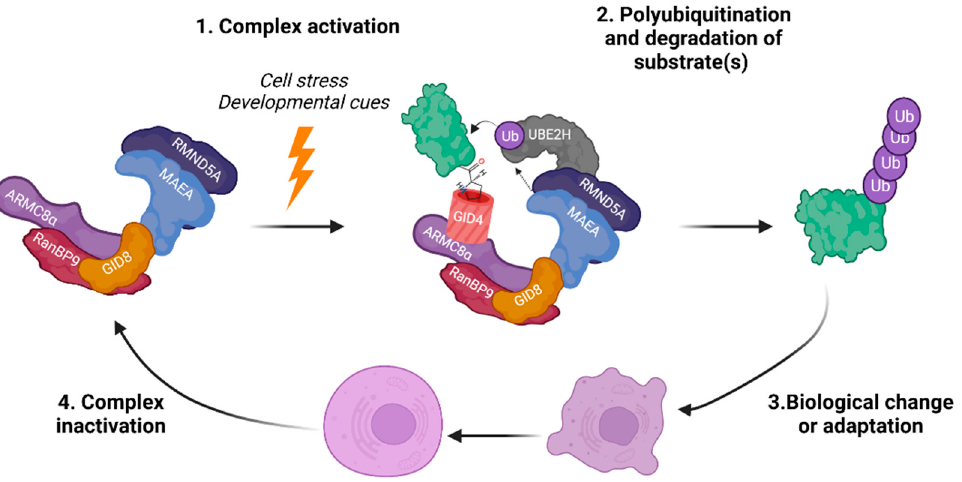
Figure 6. Proposed model of GID/CTLH complex regulation and function in returning to homeostasis. Created with Biorender.com (21 April 2022).